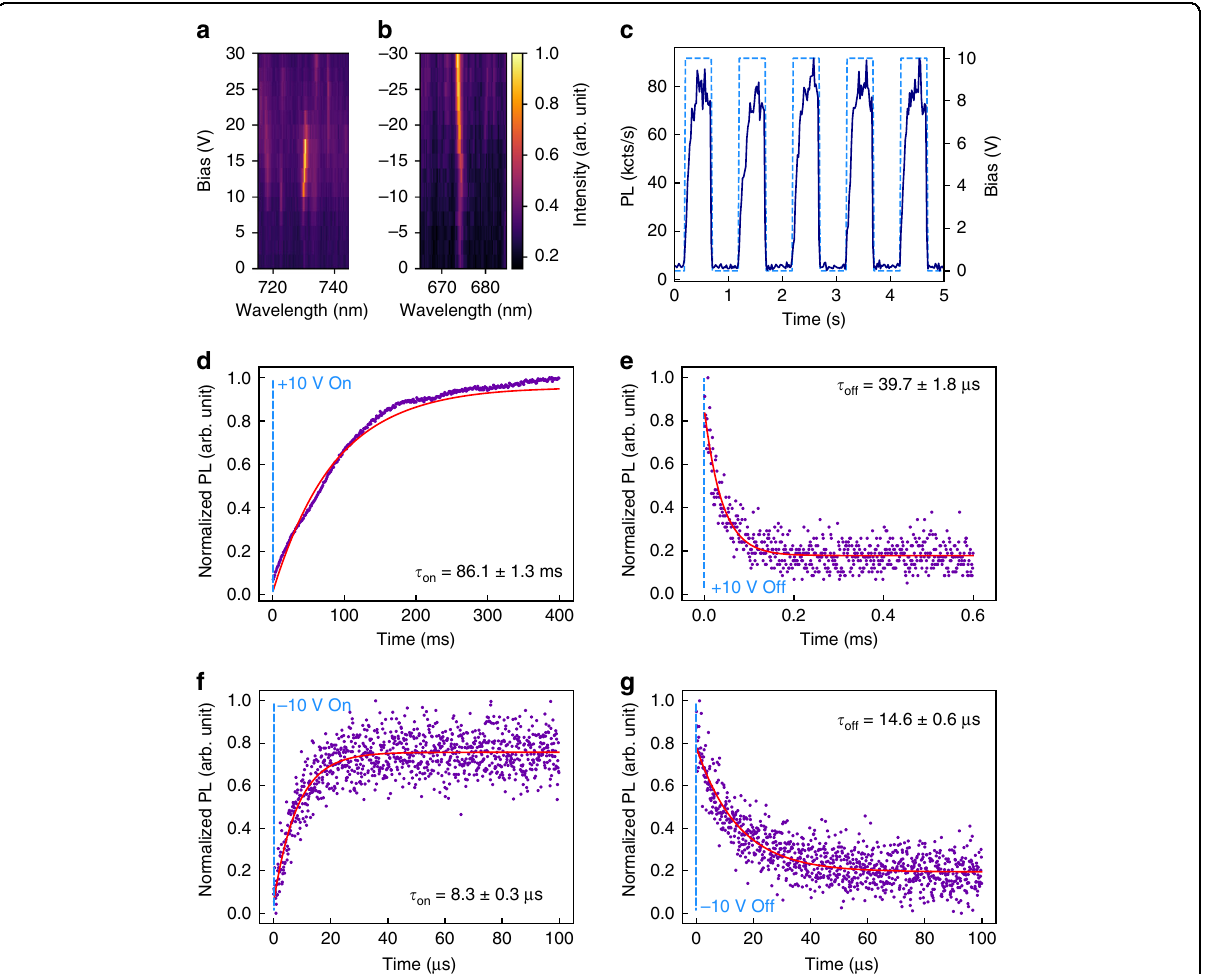
Fig. 2 Electrical control of hBN emitters in the heterostructure device. a , b Normalized PL spectra recorded from two different emitters as the bias applied to MLG varied from 0 V to + 30 V ( a ), and − 30 V ( b ). c Dynamic modulation of the emission intensity of an emitter by a square wave bias function. The bias is switched periodically between 0 V and + 10 V, as shown by the light blue trace. The fi ltered PL signal intensity detected by an avalanche photodiode (APD) is plotted in dark blue. d , e Normalized PL intensity versus time, showing the emission dynamics when the emitter is turned on ( d ) and off ( e ) by a + 10 V step function applied to the MLG electrode. The measured data are fi tted with single exponential functions, and the time constants, τ on, and τ off are 86 ms and 40 μ s, respectively. f , g Corresponding dynamics from an emitter that becomes active under negative bias, measured by applying a − 10 V step function to the MLG electrode. Under negative bias, τ on and τ off are 8 μ s and 15 μ s,